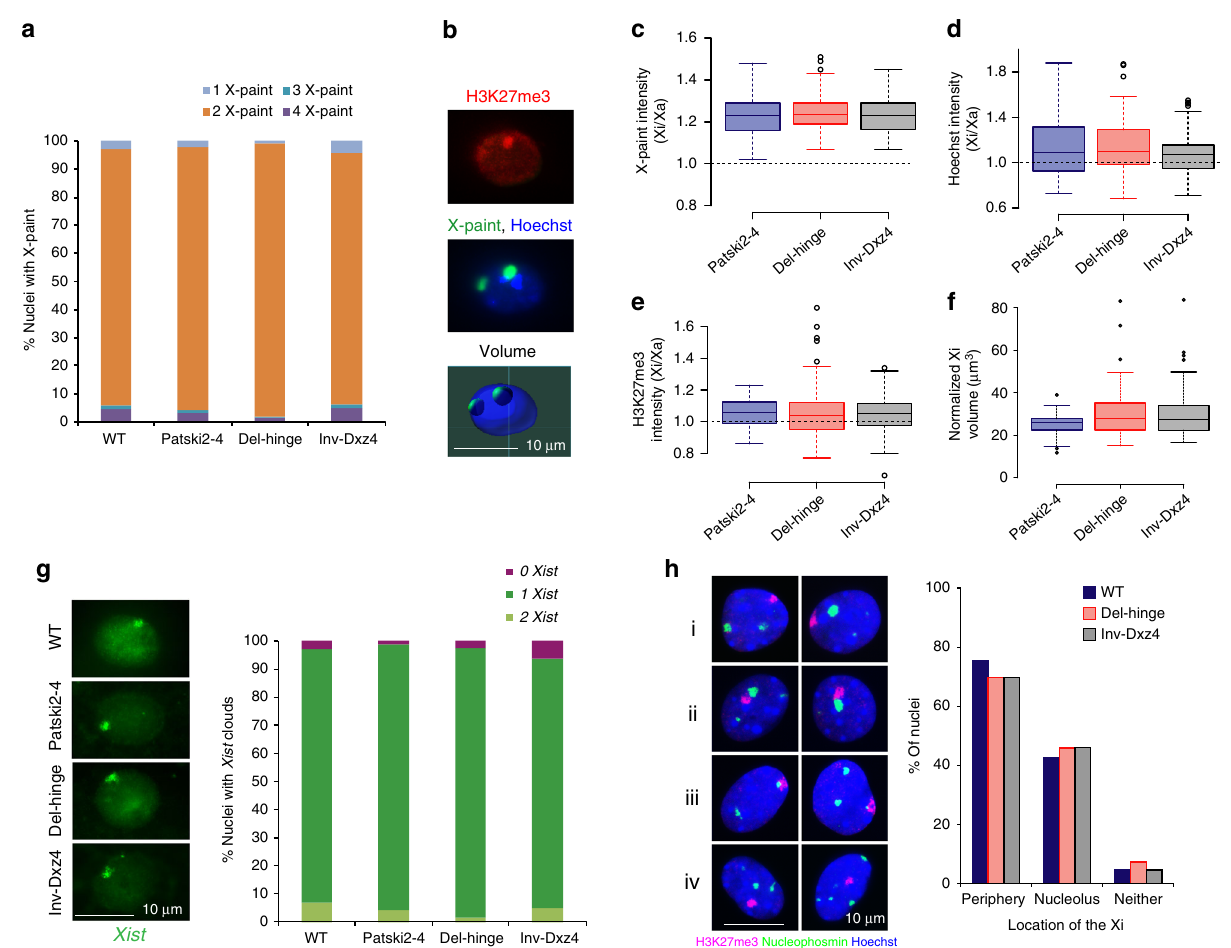
Fig. 8 Epigenetic features of the Xi in Dxz4 -edited cell lines. a Percentage of nuclei (`200 nuclei scored in each line) with 1 (light blue), 2 (orange), 3 (dark blue), or 4 (purple) X signals after DNA-FISH using an X-paint in WT, Patski2-4, Del-hinge, and Inv-Dxz4 cells. b Example of a z -stack image of a Del-hinge nucleus after H3K27me3 immunostaining (red), DNA-FISH using an X-paint (green), and Hoechst 33342 staining (blue). The Xa and Xi volumes were called based on the X-paint signals (lines show the microscope grid), using H3K27me immunostaining to identify the Xi. A 10 µ m scale is shown. c – e Box plots of fl uorescence intensities for the X-paint, Hoechst 33342, and H3K27me3 in wild-type Patski2-4 (blue), Del-hinge (red), and Inv-Dxz4 (gray) cells. No difference was detected between these lines by Wilcoxon rank sum test. Note that the Xi shows higher intensity of staining compared to the Xa. The boxes demarcate the interquartile range (IQR) with median. Whiskers are ±1.5 times the IQR. Outliers plotted as individual points. f Box plots of the Xi volume normalized to the Xa volume show a slight but signi fi cant (by Wilcoxon rank sum test) increase of the median value in the Xi volume in Del-hinge (7%; p -value = 0.01) and in Inv-Dxz4 (6%; p -value = 0.03). Boxes as described in c – e . g Left, examples of nuclei from WT, Patski2-4, Del-hinge, and Inv- Dxz4 cells after RNA-FISH for Xist (green; 10 µ m scale shown). Right, bar plots of the percentage of nuclei (`200 nuclei scored in each line) with 0 (magenta), 1 (green), or 2 (yellow/green) Xist RNA clouds. The majority of nuclei have one Xist cloud with no signi fi cant difference between cell lines by Fisher ’ s exact test. See Supplementary Fig. 10a, b for Xist expression analyses. h Left, examples of nuclei stained with Hoechst 33342 (blue) and immunostained for H3K27me3 (red) to locate the Xi, and for nucleophosmin (green) to locate the nucleolus, show the Xi located either at the periphery (i), near the nucleolus (ii), sandwiched between periphery and nucleolus (iii), or at neither of these locations (iv). A 10 µ m scale is shown. Right, the percentage of nuclei with the Xi near the periphery, the nucleolus, and at neither of these locations does not signi fi cantly differ between WT (blue), Del- hinge (red), and Inv-Dxz4 (gray) by Fisher ’ s exact test. A total of ~200 nuclei were scored per cell type by at least two different